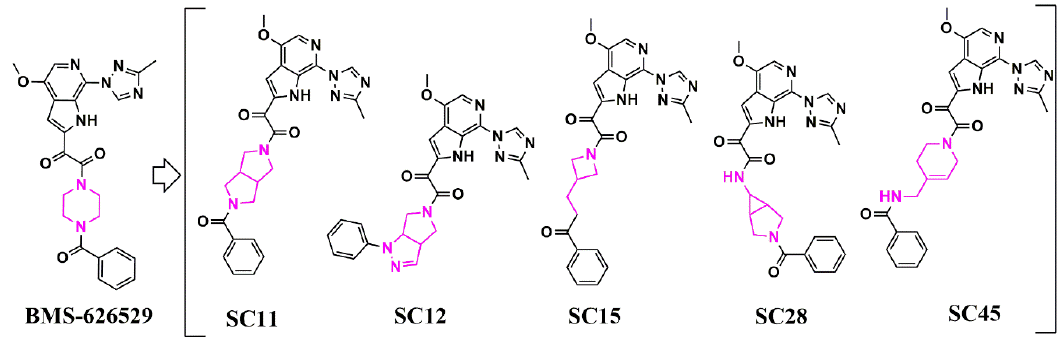
Figure 14. Scaffold hopping in the core region of an HIV ‐ 1 entry inhibitor. Structural changes in the Figure 14. Sca ff old hopping in the core region of an HIV-1 entry inhibitor. Structural changes in the core region between each compound are highlighted in pink. core region between each compound are highlighted in pink. Table 3. Specificity and potency (in µ M) of SC compounds against HIV-1J R-CSF, HIV-1 B41, HIV-1